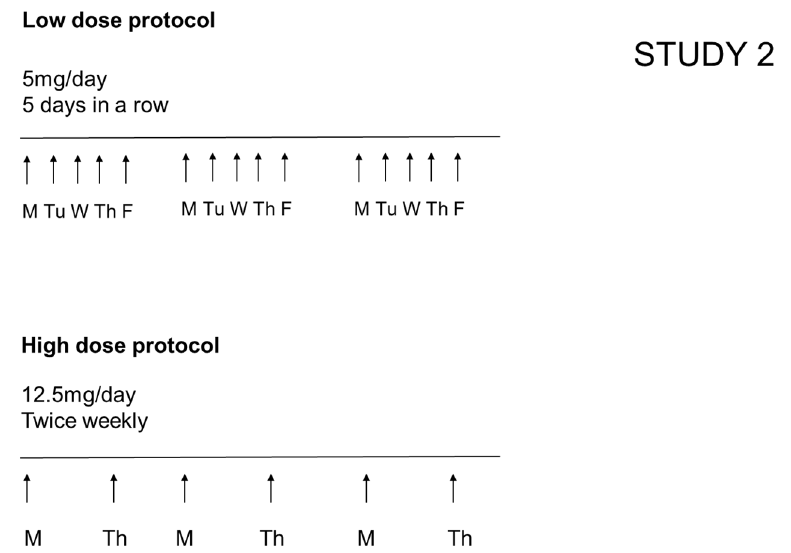
Figure 2. Protocol for allergen challenge in Study 2 aimed to address the effect of daily dose of allergen while keeping the weekly dose the same (25 mg/dog) and the duration the same (3 weeks). In the low dose protocol, dogs were exposed to house dust mites every day of the week, 5 days in a row, Monday, Tuesday, Wednesday, Thursday and Friday (M, Tu, W, Th, F). In the high dose protocol, dogs were challenged twice weekly with 12.5 mg of allergen, Monday and Thursday (M, Th).